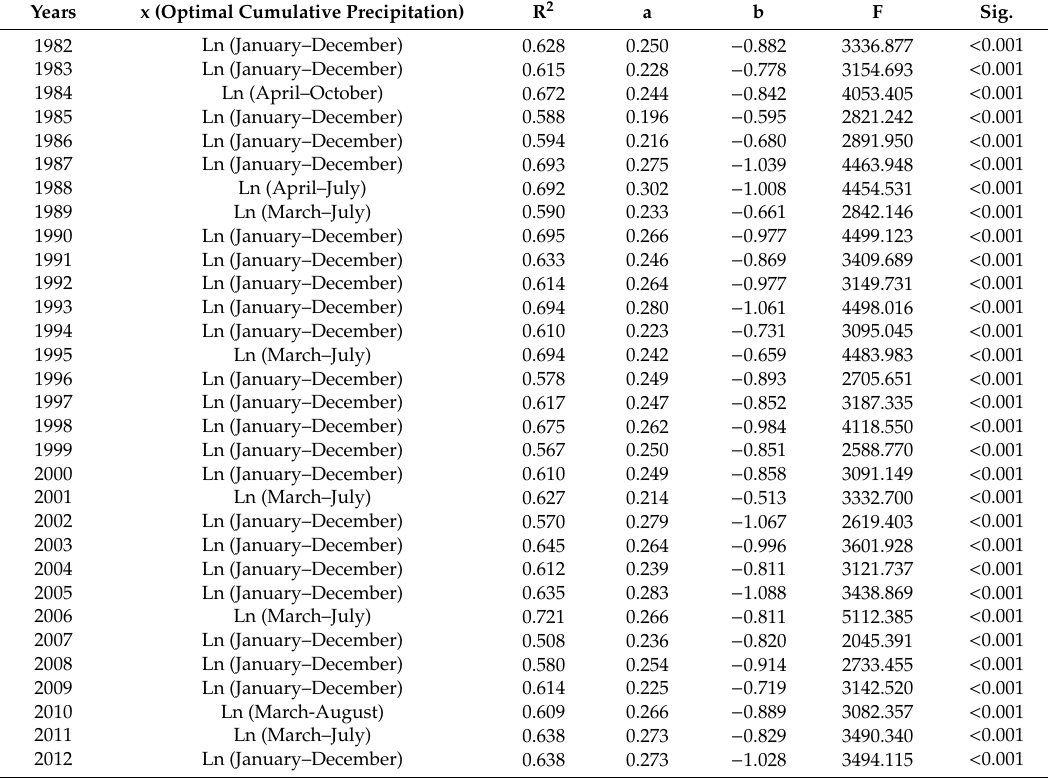
Table 2. Linear Regression Relationship between Normalized Di ff erence Vegetation Index (NDVI) max and Optimal Cumulative Precipitation during 1982–2012 in Northern